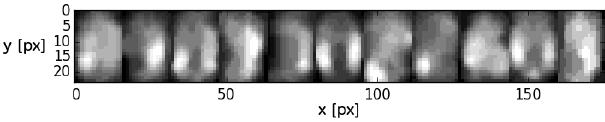
Figure 15. The extracted and normalised digits of image C (Fig. 6). Prediction: 89 093 02